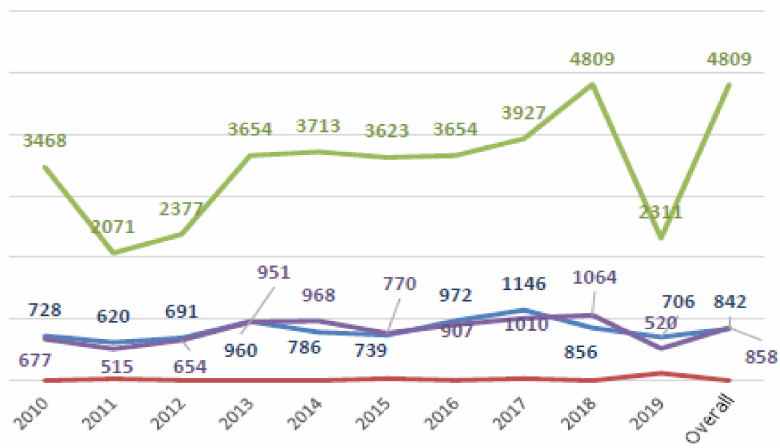
Figure 3. Latency trends by year (average in blue; minimum in red; maximum in green; standard deviation in violet).